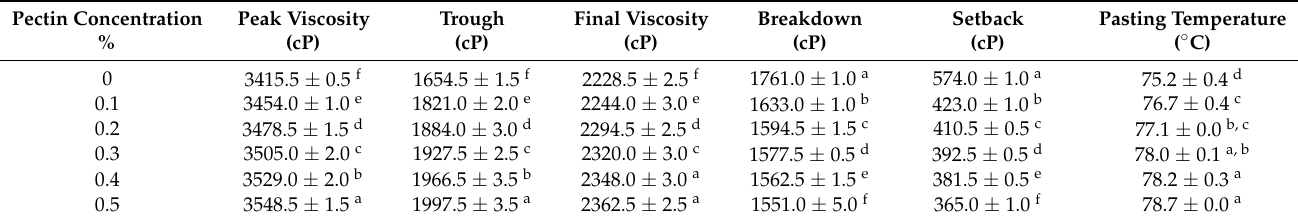
Table 1. Pasting properties of the WRS and the WRS–PEC mixtures